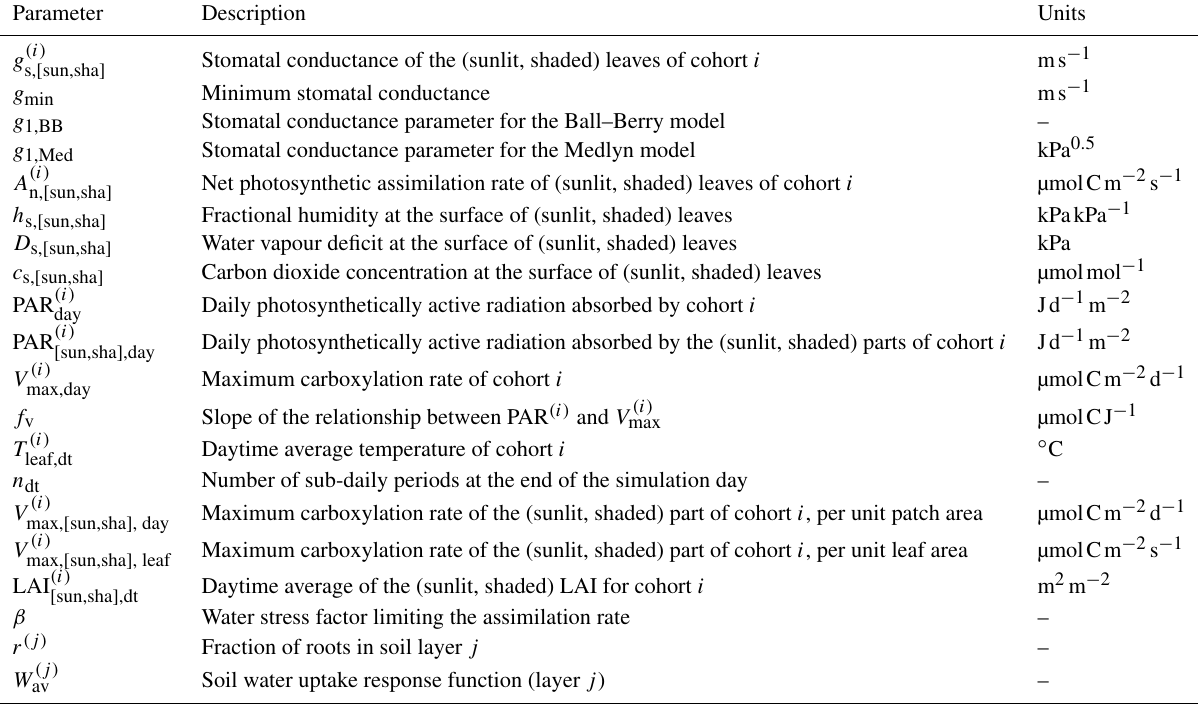
Table B4. Assimilation and stomatal conductance. Parameter Description Units Stomatal conductance of the (sunlit, shaded) leaves of cohort i Minimum stomatal conductance Stomatal conductance parameter for the Ball–Berry model – Stomatal conductance parameter for the Medlyn model kPa 0 . 5